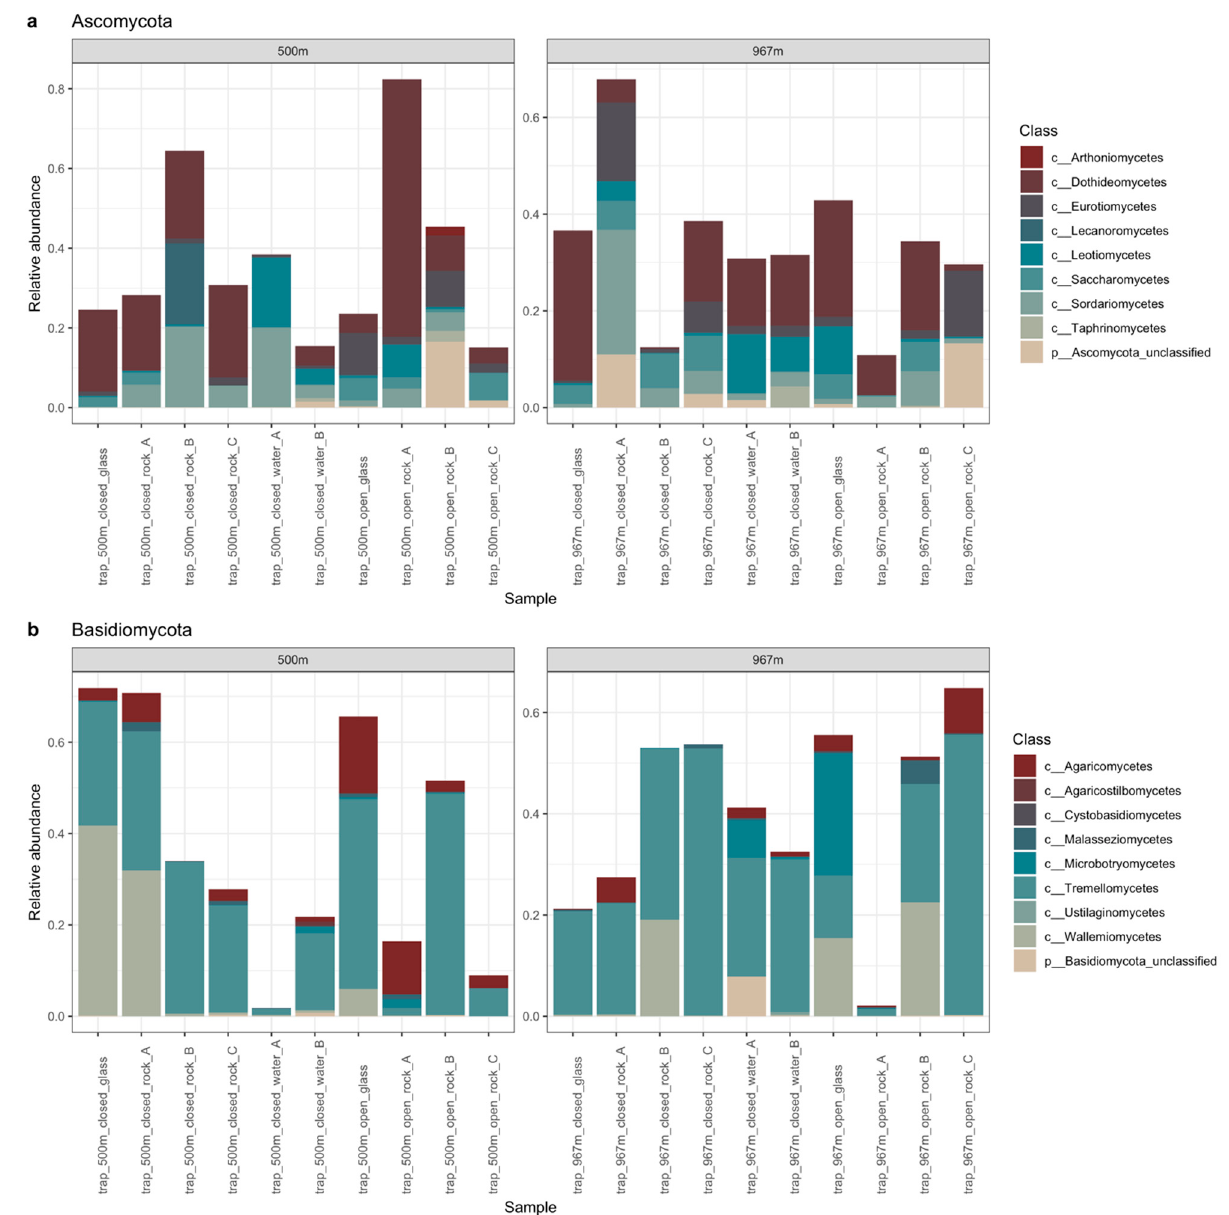
Figure 5. The relative abundance of basidiomycotal ( a ) and ascomycotal ( b ) classes at 500 and 967 m depths. In the legend on the right, c in front of the taxon name indicates identification to class level, p indicates identification to phylum level.